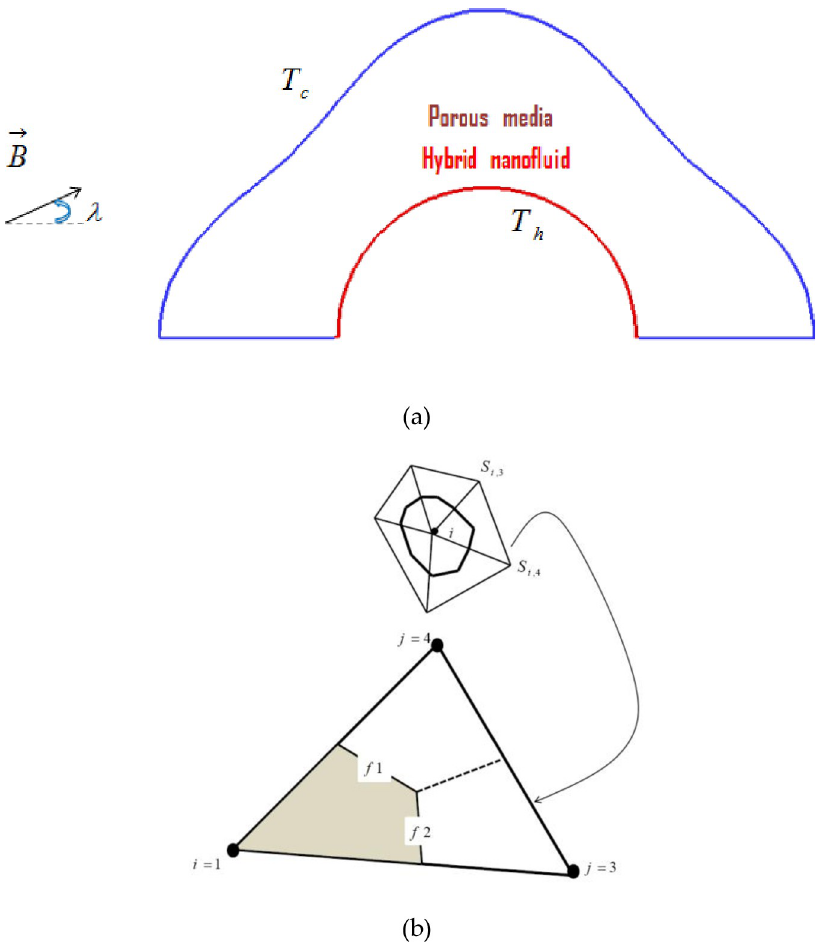
Fig 1. (a) Permeable container filled with hybrid nanofluid (b) CVFEM